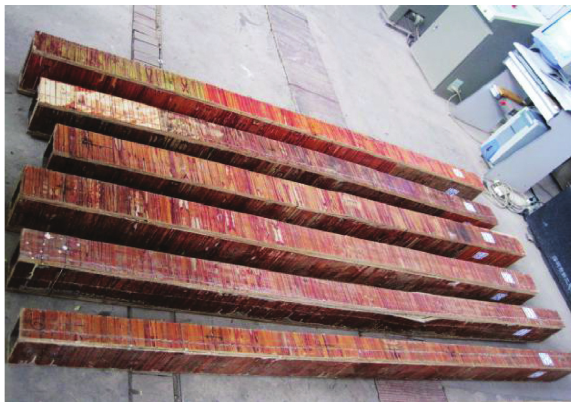
Figure 3: Specimens of composite beam. Note: one specimen was omitted due to the invalid result.